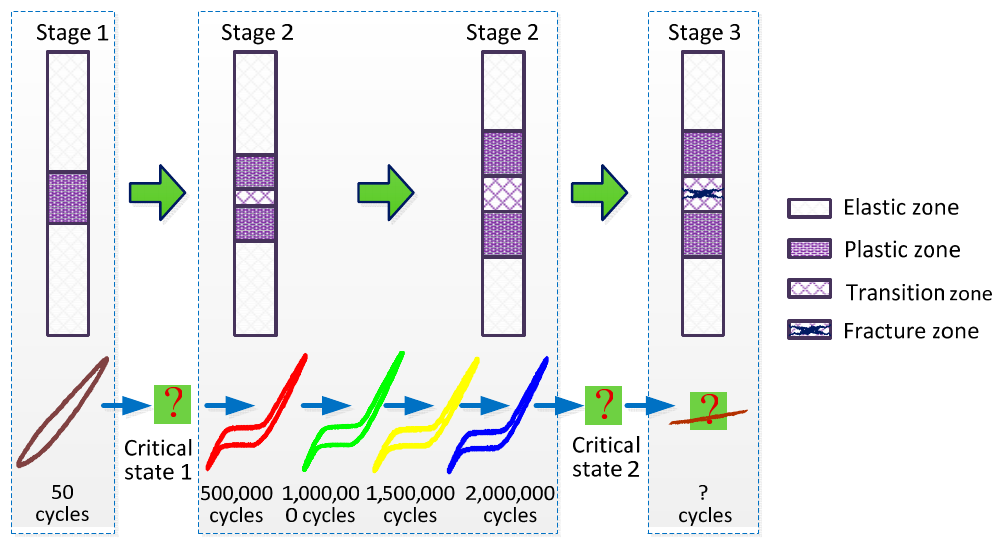
Figure 7. Medium-level explanation of PE samples under cyclical loads.